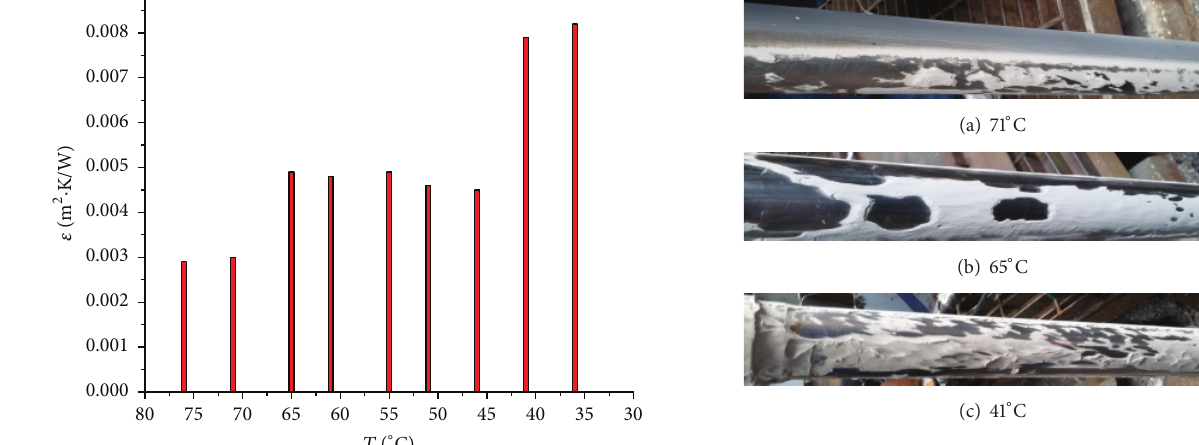
Figure 10: Ash deposited on the outer wall of double